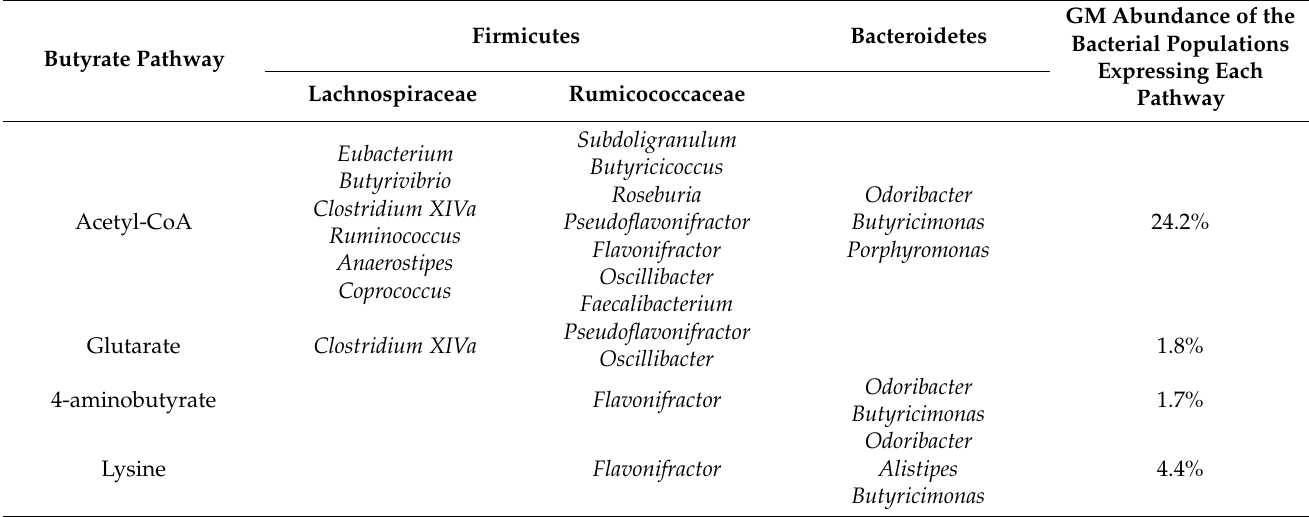
Table 1. Classification of the main butyrate-producing bacteria from the Firmicutes and Bacteroidetes phyla according to the different pathways they use to synthesize butyrate (from [33]).